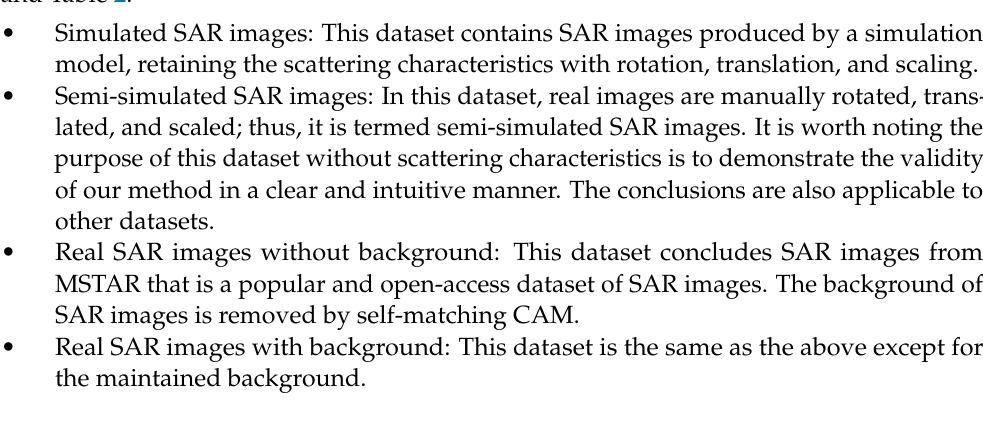
Table 2. The detailed information of each